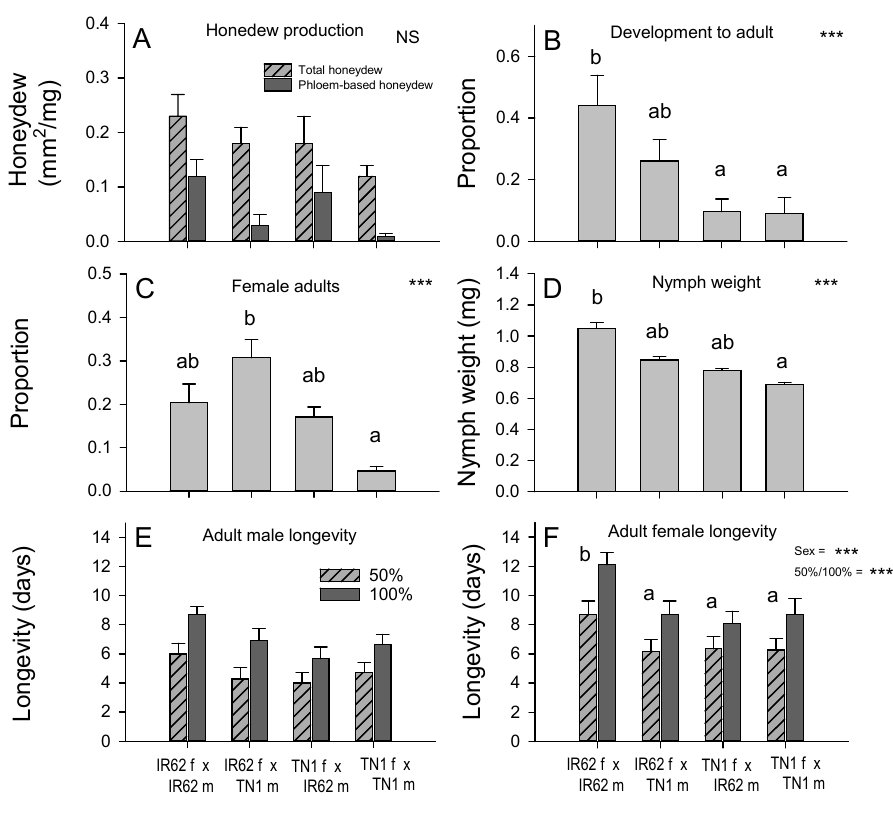
Figure 2. Performance of planthopper nymphs ( A – D ) and adults ( E , F ) derived (F1) from controlled mating of virulent and non-virulent parents when feeding on the resistant rice variety IR62. Perfor- mance was compared by recording ( A ) honeydew production, ( B ) nymph development, ( C ) pro- portion of adults that were female, ( D ) nymph weight, ( E ) the time to 50% and 100% mortality of adult males, and ( F ) the time to 50% and 100% mortality of adult females (i.e., longevity). Standard errors are indicated (N = 12). NS = no significant parent effect, *** = highly significant parent effect ( p < 0.001). Lowercase letters indicate homogenous groups (Tukey p > 0.05). Data in ( A ) was ranked, ( B , C ) arcsine-transformed, and ( D ) log-transformed before analyses. More eggs were laid by planthoppers with a virulent female parent than planthop- pers with two avirulent parents (eggs: F 3,44 = 5.723, p = 0.002: Figure 3A inset). However, a higher proportion of the F2 (IR62 ♀ × IR62 ♂ ) eggs were non-viable compared to eggs from all other mating combinations (proportion of eggs that were non-viable: F 3,44 = 6.937, p = 0.001: Figure 3A). Overall, more viable eggs were laid by F1 (IR62 ♀ × IR62 ♂ ) females than by F1 (TN1 ♀ × TN1 ♂ ) females (viable eggs: F 3,44 = 4.524, p = 0.008: Figure 3A). More F2 nymphs were produced on IR62 plants by F1 (IR62 ♀ × IR62 ♂ ) adults than by F1 (TN1 ♀ × TN1 ♂ ) adults in the population build-up bioassay (number of nymphs: F 3,44 = 4.950, p = 0.005: Figure 3B inset). Relative proportions of nymphal instars differed between mating treatments (instars: Wilk’s Lambda = 0.560, F 9,102 = 3.056, p = 0.003). Pro- portions of 1st and 2nd instars were similar across treatments (1 instar: F 3,44 = 1.603, p = 0.202; 2 instar: F 3,44 = 1.695, p = 0.182), but there were fewer 3rd instars on plants with F1 (TN1 ♀ × TN1 ♂ ) adults (3 instar: F 3,44 = 6.665, p = 0.001: Figure 3B).